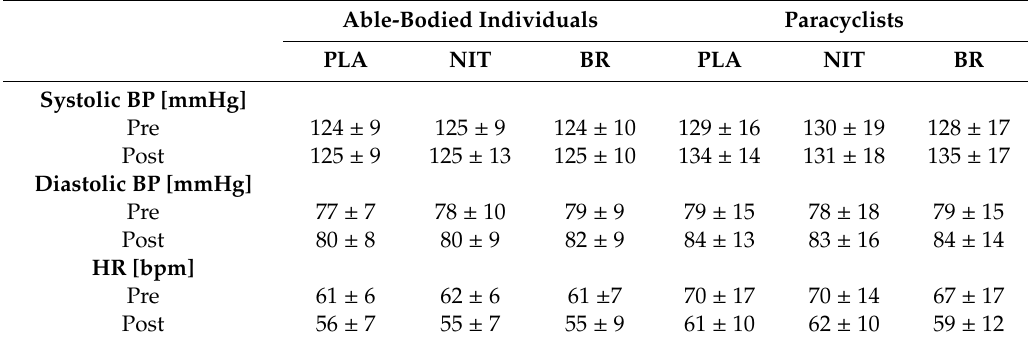
Table 2. Blood pressure and heart rate before and after ingestion of the supplements. Able-Bodied Individuals